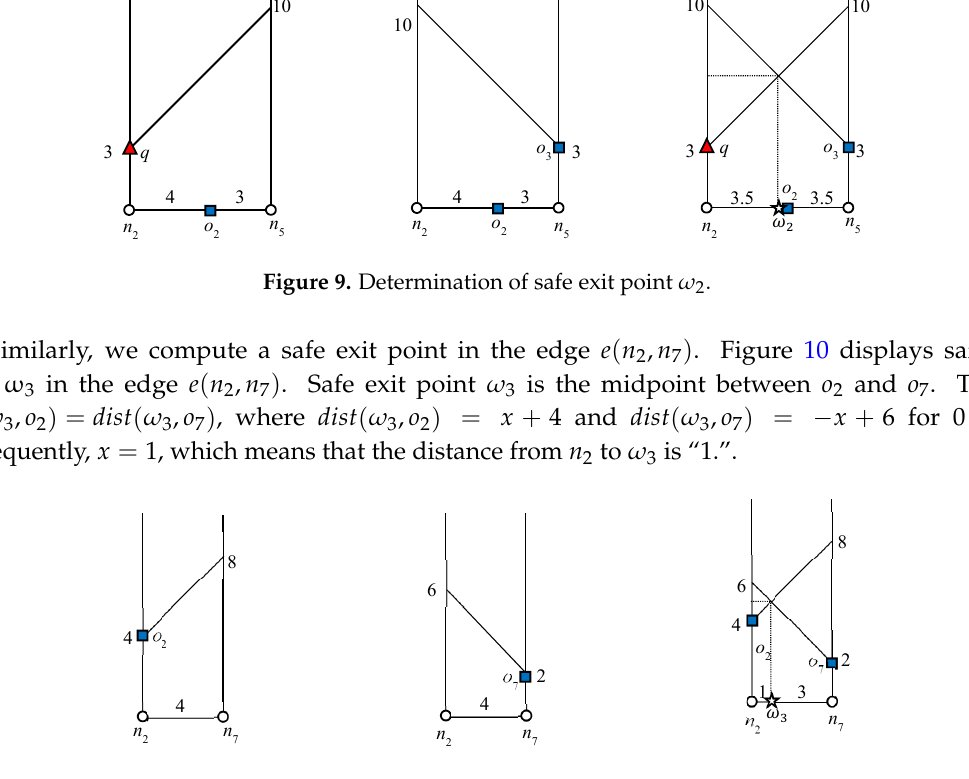
Figure 8. Determination of safe exit point (cid:2033) (cid:2869) .